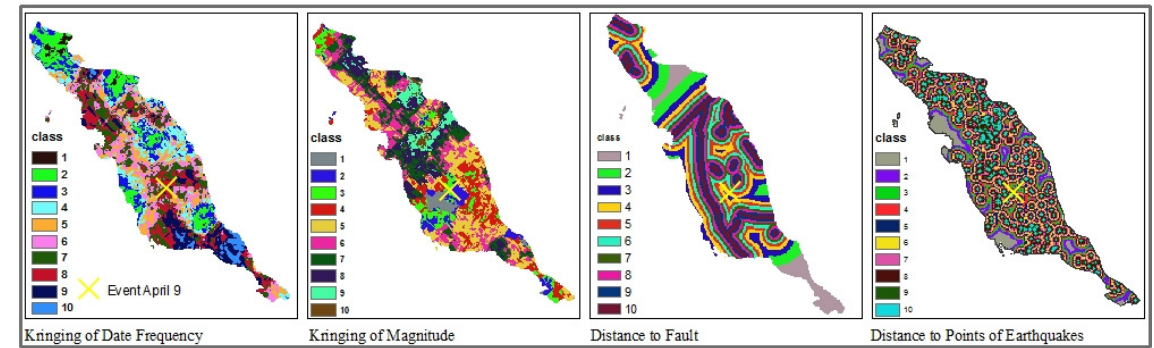
Figure 3: The four criteria are classified in 10 classes by Quantile Classification Method. The yellow cross mark is the location of the earthquake event in each of the four